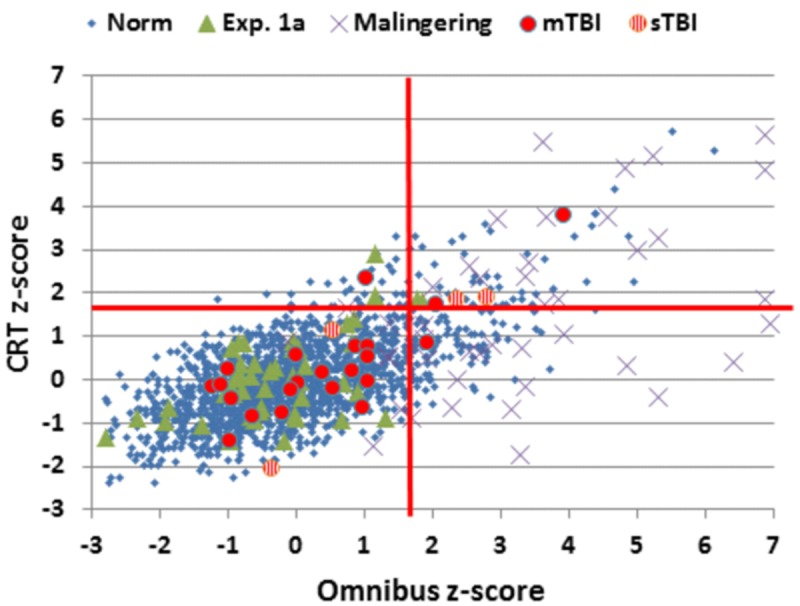
Choice reaction time and Omnibus z-scores. Data from control subjects in the normative data (Norm) and Experiment 1A, simulated malingerers (Experiment 2), and TBI patients (Experiment 3). Z-scores were calculated based on age- and computer-use regression slopes from the normative data. Patients with mild TBI (mTBI, filled red circles) and severe TBI (sTBI, circles with vertical red stripes) are shown separately. The data from four simulated malingerers with z-scores outside the range of the figure are not shown.